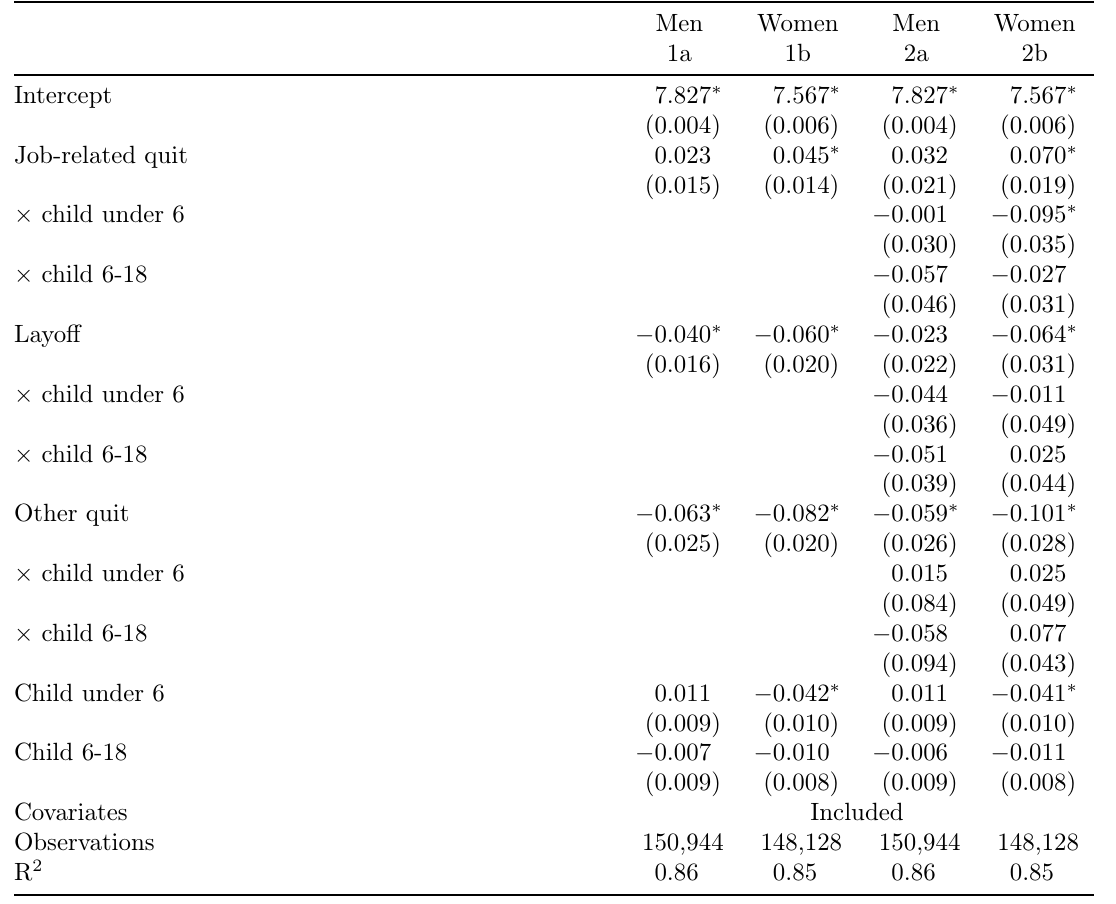
Table 2: Person-level fixed effects regression coefficients for the effect of job mobility (4 months prior) on the log of monthly earnings, SIPP